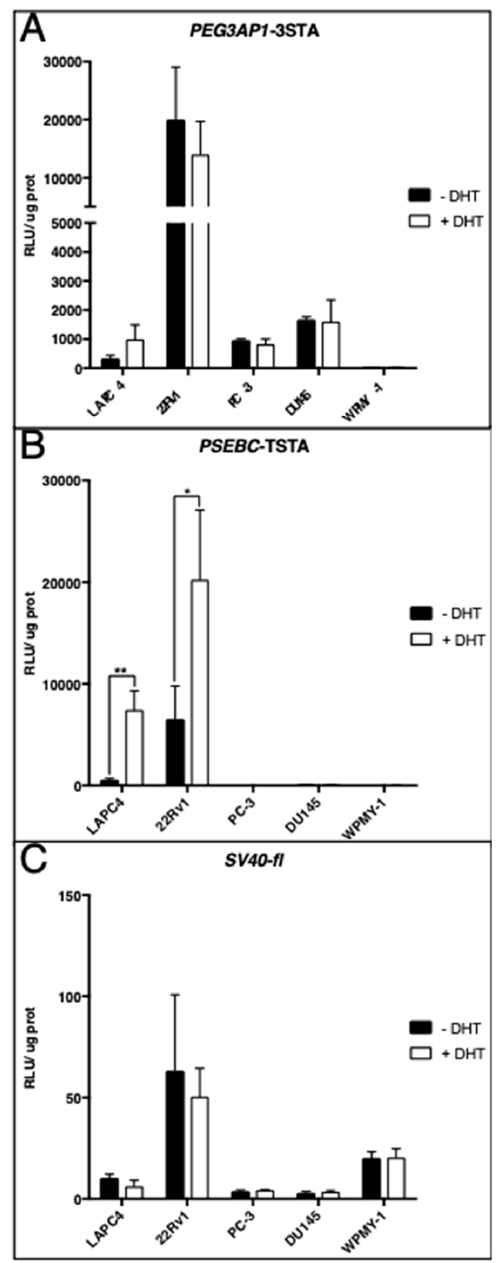
Figure 2. The PEG3AP1 -3STA system was not androgen-dependent. LAPC4, 22Rv1, PC-3, DU145 (PCa), and WPMY-1 (normal human fibroblastic prostate) cells were transduced with ( A ) PEG3AP1 -3STA; ( B ) PSEBC -TSTA; or ( C ) SV40-fl adenovirus at 5 MOI in the presence or absence of DHT for 72 h. Firefly luciferase activity was assayed. The relative luciferase activity was normalized by protein content in each well. Data represent triplicate ± SD, (* p < 0.05, ** p < 0.01).